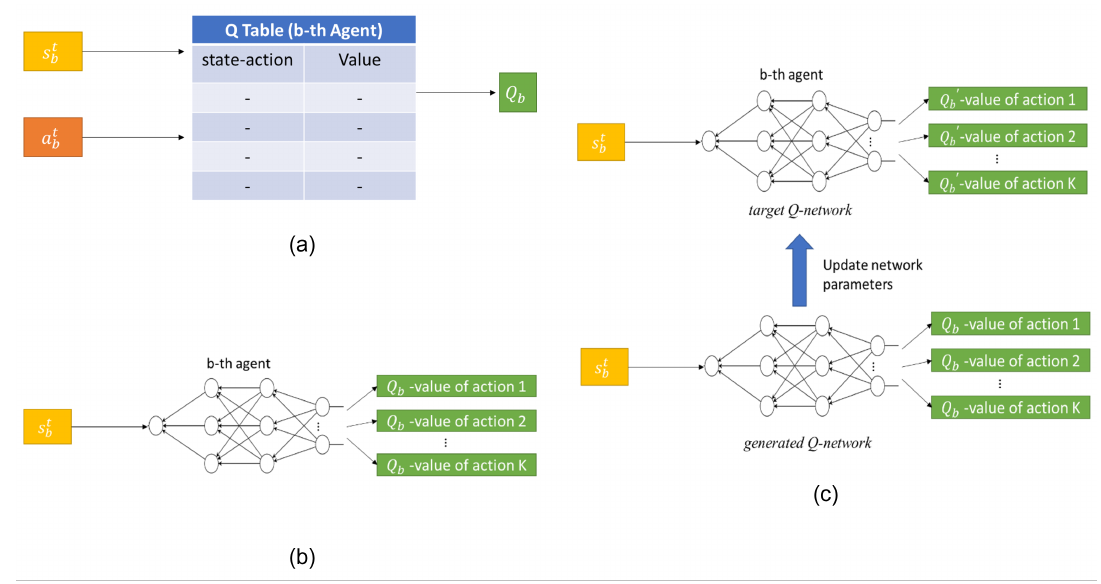
Figure 8. The agents are trained from the acquired observation data using an RL algorithm to obtain the agents’ policies and update the resources. ( a ) Q-Learning (QL): Table Q is generated for each agent and will represent the Q b value for each state–action pair. ( b ) Deep Q-Learning (DQL): DQL uses a neural network to approximate the function of the Q b value. ( c ) Double Deep Q-Learning (DDQL: Each agent in DDQL uses two neural networks with the same architecture to learn and predict what action to perform at each